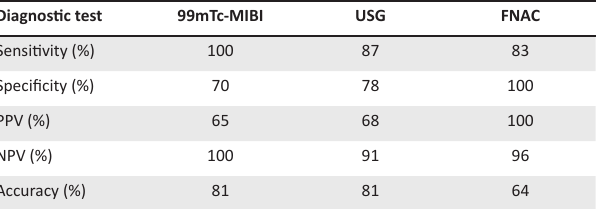
TABLE 2: Comparison of the diagnostic performances of 99mTc-MIBI, ultrasonography and fine needle aspiration cytology in the evaluation of thyroid nodules.